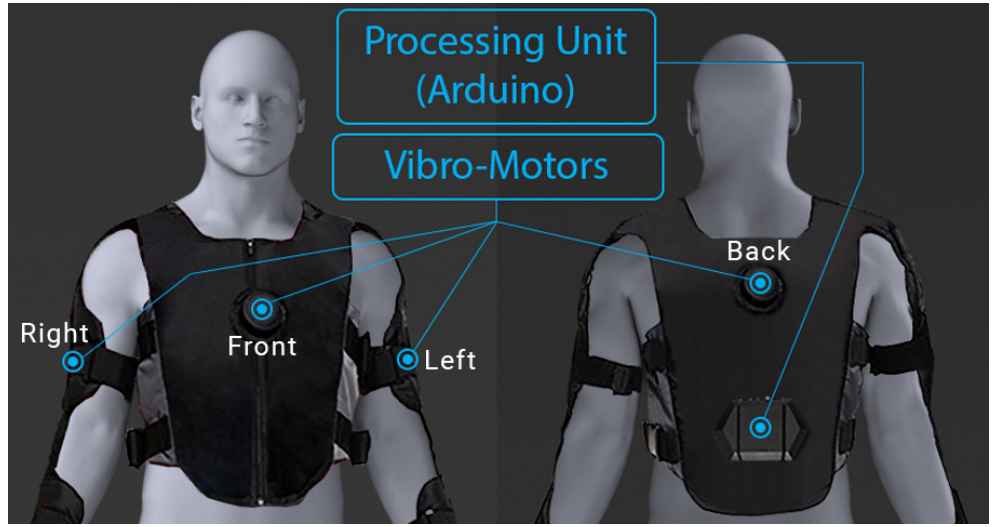
Figure 1. The concept design of our proposed VR